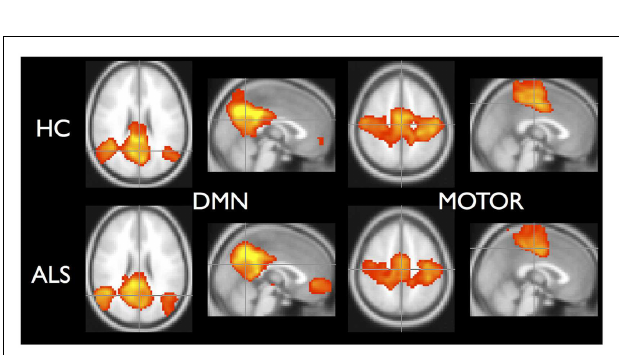
FIGURE 4 | Distribution of time of scan since symptom onset and observed distribution ofALSFRS-r in ourALS participant cohort . Inserted distributions are for the true-positive and false-negative classified groups.